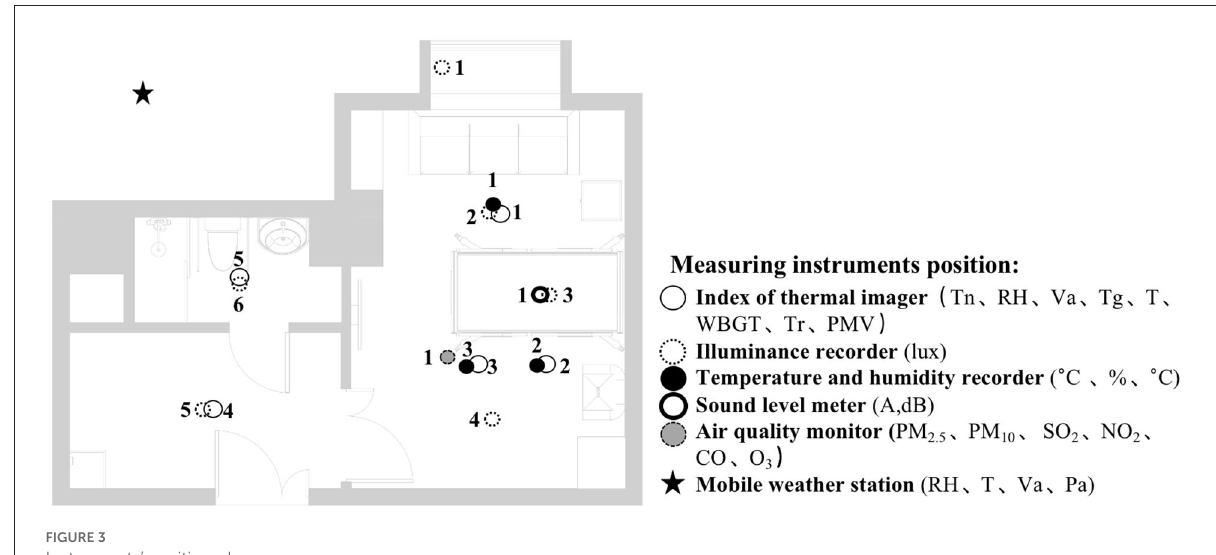
FIGURE3 Instruments’ position